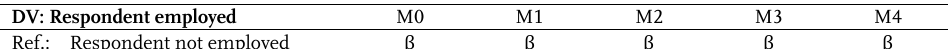
Table 2 : Linear multilevel probability models for female immigrants’ employment (M1, M2 & M3)